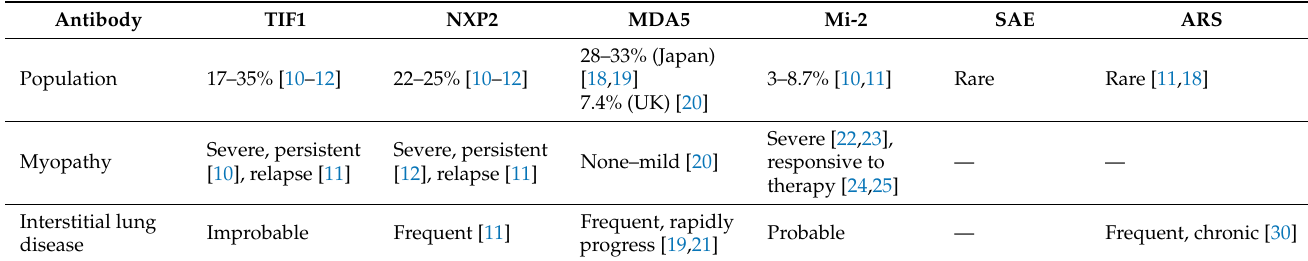
Table 1. Subgroups of juvenile dermatomyositis characterized by myositis-specific